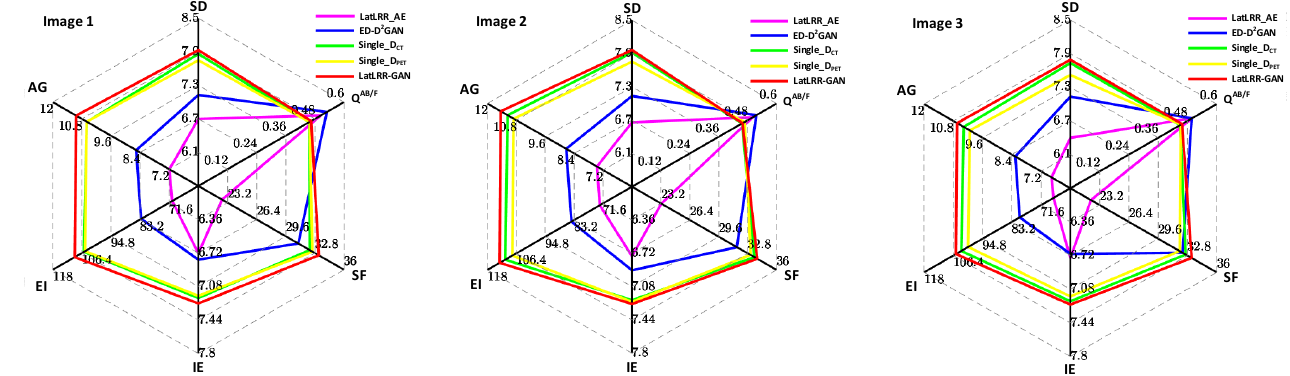
Figure 8. The evaluation metrics coefficient radar maps of CT lung window images and PET images about the ablation experiments. Method 1: LatLRR_AE; Method 2: ED-D 2 GAN; Method 3: Sin- gle_D CT ; Method 4: Single_D PET ; Method 5: LatLRR-GAN. Table 3. The fused images’ evaluation metric results of CT lung window images and PET images about the ablation experiments. Method 1: LatLRR_AE; Method 2: ED-D 2 GAN; Method 3: Sin- gle_D CT ; Method 4: Single_D PET ; Method 5: LatLRR-GAN. The best evaluation metric values are rep- resented in red; the second-best evaluation metric values are represented in blue. Images Methods AG EI